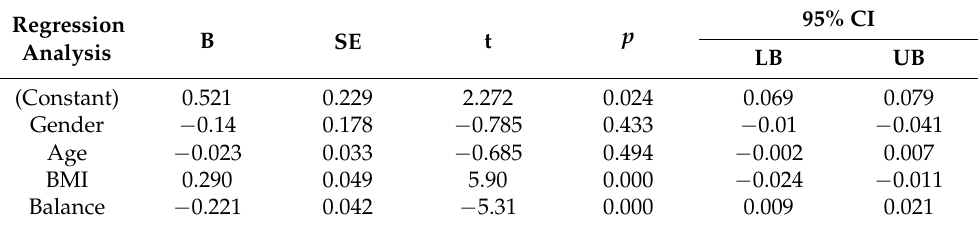
Table 3. Multiple linear regression to estimate the effect of exploratory variables (gender, age, BMI, and balance) on gait